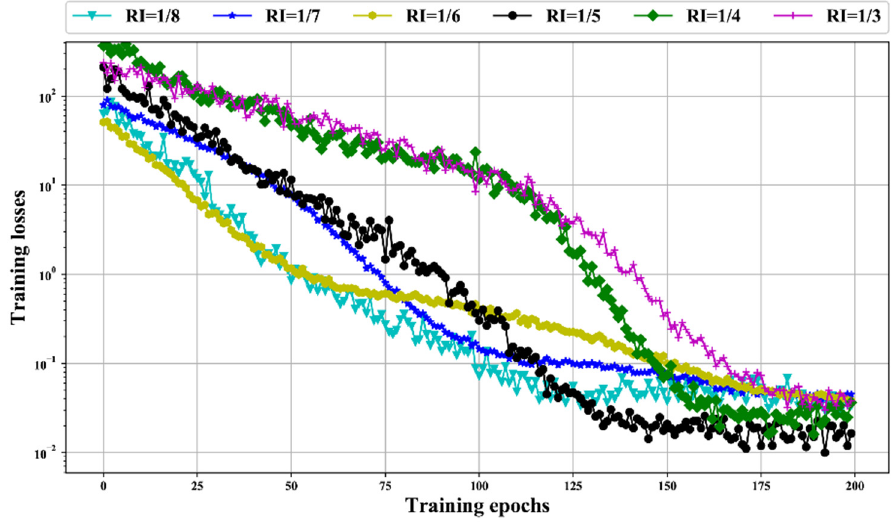
Figure 9. BLSTM training losses in Semi-log coordinate using data sets with various RIs.